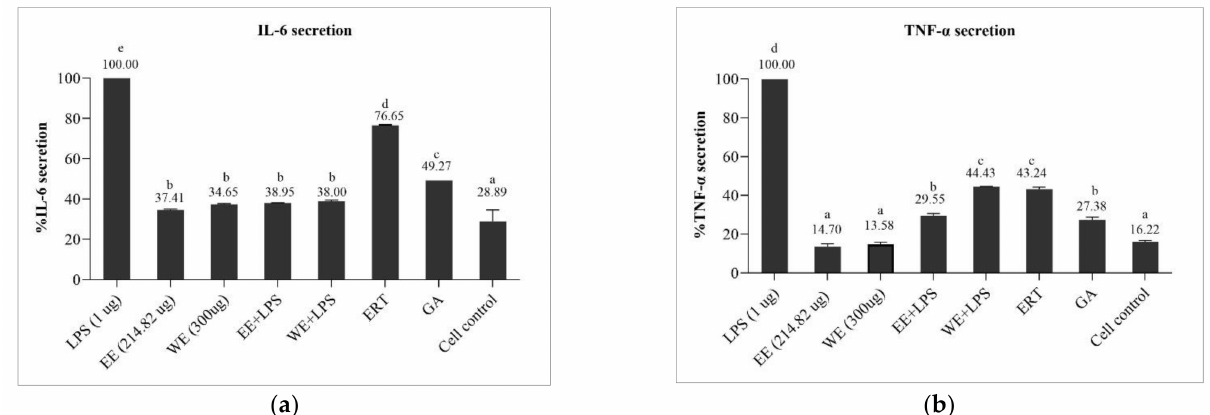
Figure 6. The IL-6 ( a ) and TNF- α ( b ) secretion on HaCaT cells when treated with LPS alone, extract alone, pre-treatment with brown A. bisporus ethanol extract (EE), brown A. bisporus water extract (WE), ergothioneine (ERT), gallic acid (GA), and non-treated (cell control). Different letters above the bars indicate statistically significant differences ( p <